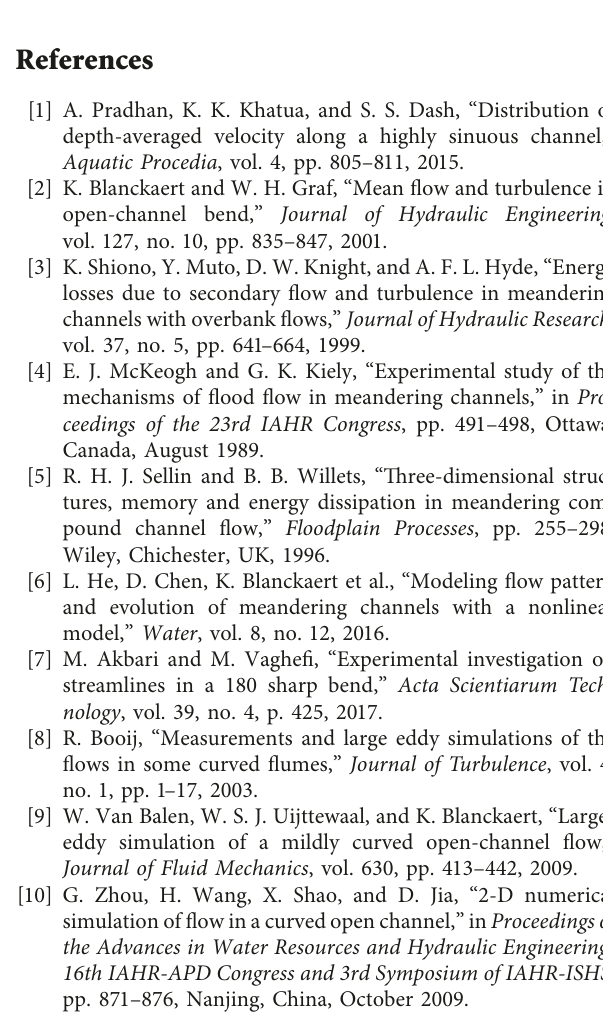
Figure 18: Depth-averaged velocity distribution: (a) CCHE2D simulation and (b)